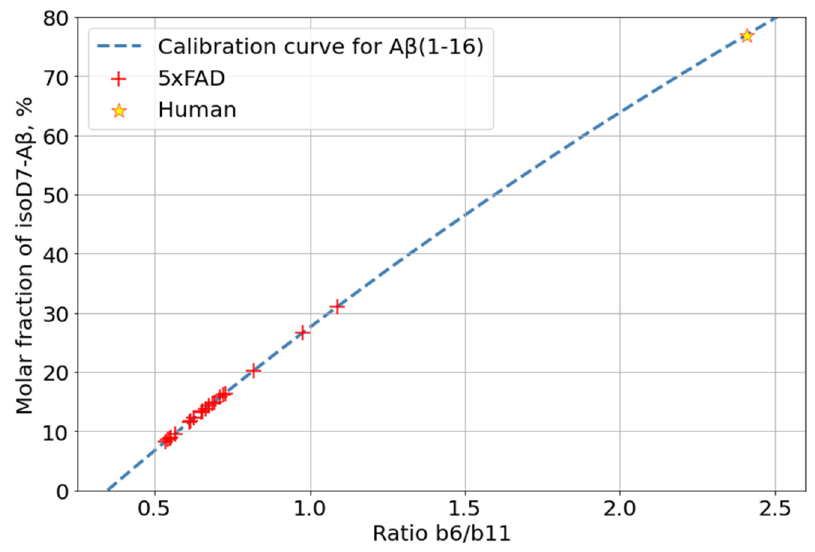
Figure 5. Comparison of isoD7-A β content measured for 5xFAD and human AD brain